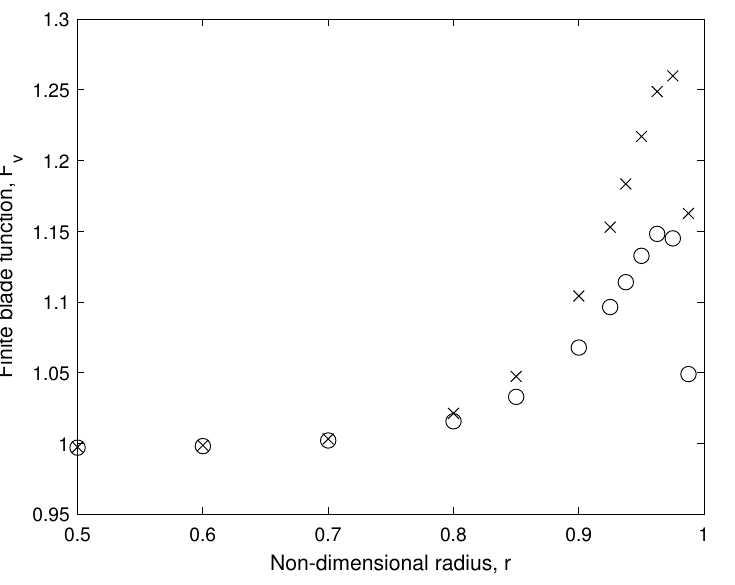
Figure 5. Flow angle, ϕ ,(in degrees) at the blades for the conditions of Figure 4.